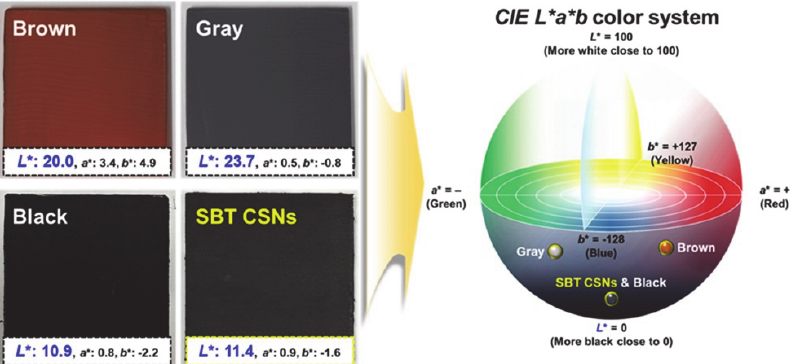
Figure 10. Digital photographs of SBT CSN-based paint and black, brown, and gray paints applied on glass substrates and their color descriptions in CIE L*a*b* system. Black and SBT CSN-based paints displayed comparable blackness ( L* < 20).